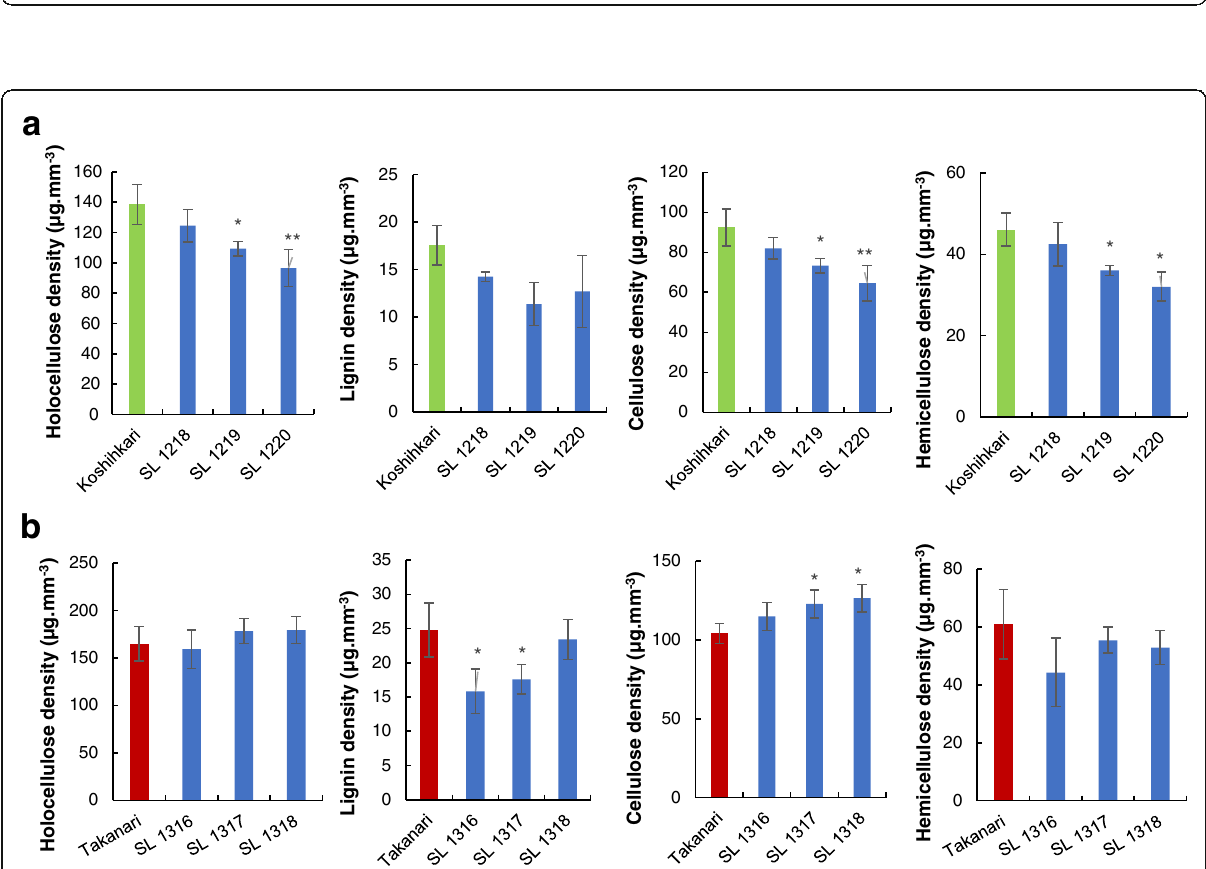
Fig. 6 Cell wall material densities in a K-CSSLs and b T-CSSLs of chromosome 5 in 2016. Data are expressed as the mean ± SD. *, and ** represent significant differences at 5 and 1% level,